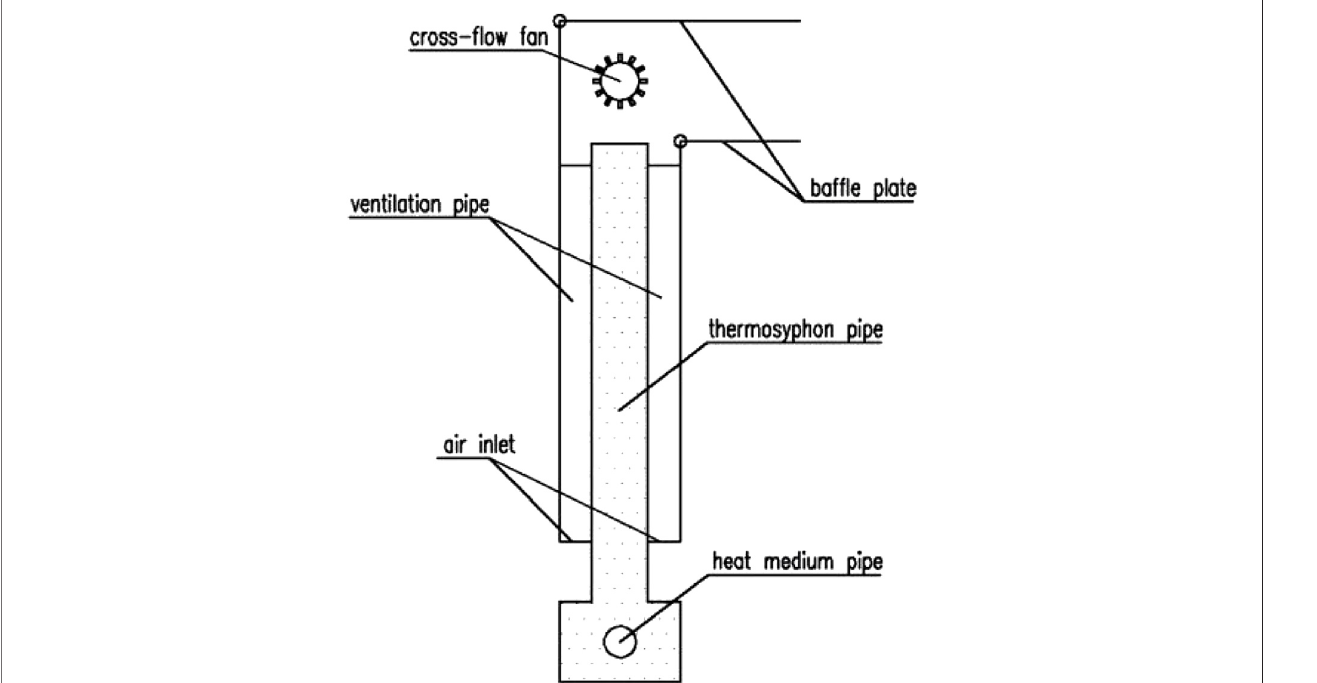
FIGURE 5 | Structural diagram of radiation and convection coupled heat transfer radiator.